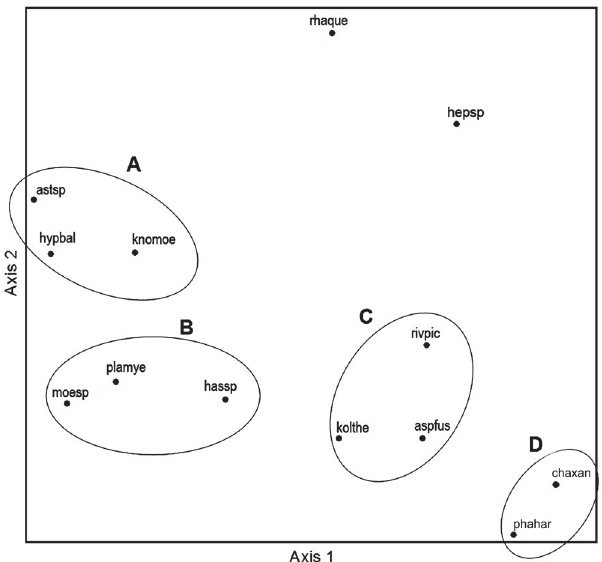
Fig. 3. Non-metric multidimensional scaling analysis for the 13 more abundant fish species’ diet found in the Bananal stream subbasin, Paranoá Lake basin, DF. Indication of four groups A, B, C and D. Species abbreviations: Aspidoras fuscoguttatus (aspfus), Astyanax sp. (astsp), Characidium xanthopterum (chaxan), Hasemania sp. (hassp), Hyphessobrycon balbus (hypbal), Heptapterus sp. (hepsp), Knodus moenkhausii (knomoe), Kolpotocheirodon theloura (kolthe), Moenkhausia sp. (moesp), Phalloceros harpagos (phahar), Planaltina myersi (plamye), Rhamdia quelen (rhaque) and Rivulus pictus